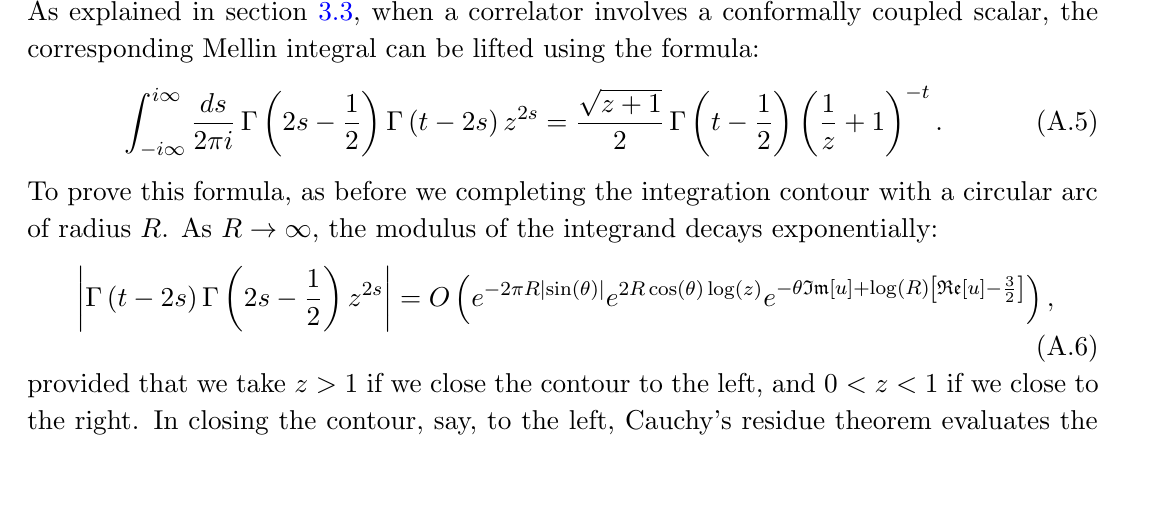
JHEP01(2020)090